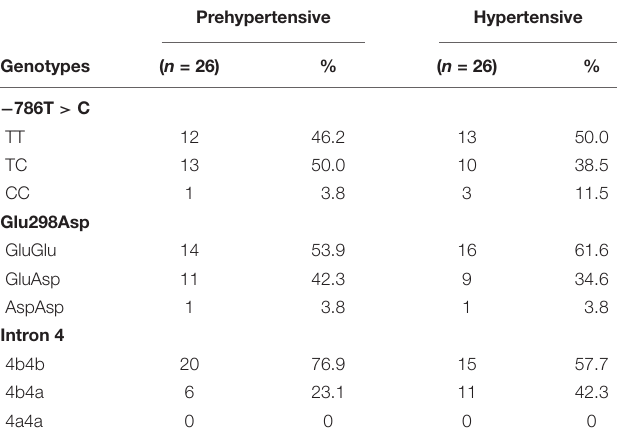
TABLE 1 | Participants’ genotypes